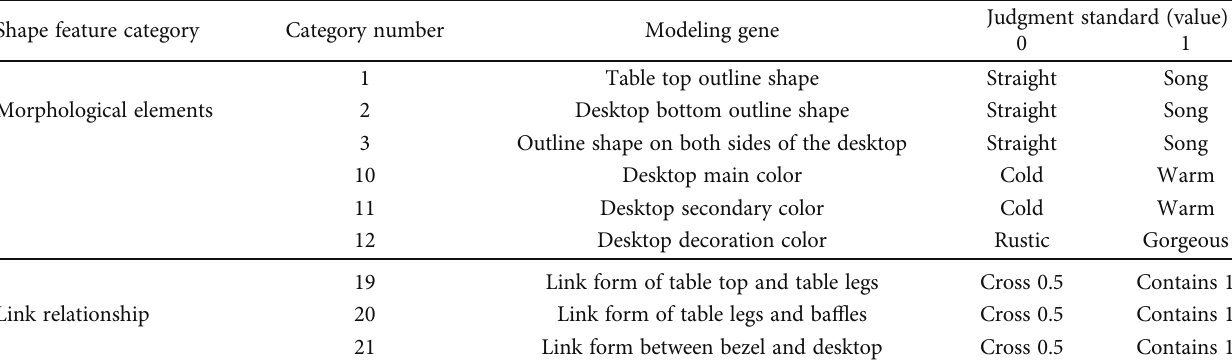
Figure 1: Modeling evolutionary design model with product semantic constraints. Table 1: Modeling genes and judgment criteria of panel